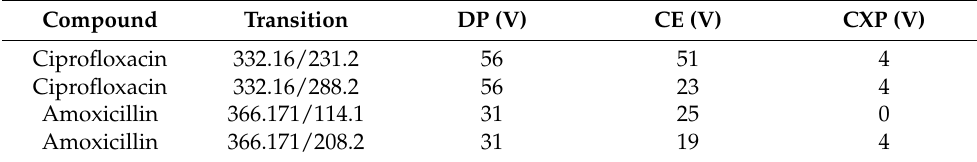
Table 2. Optimization parameters DP, CE, CXP for